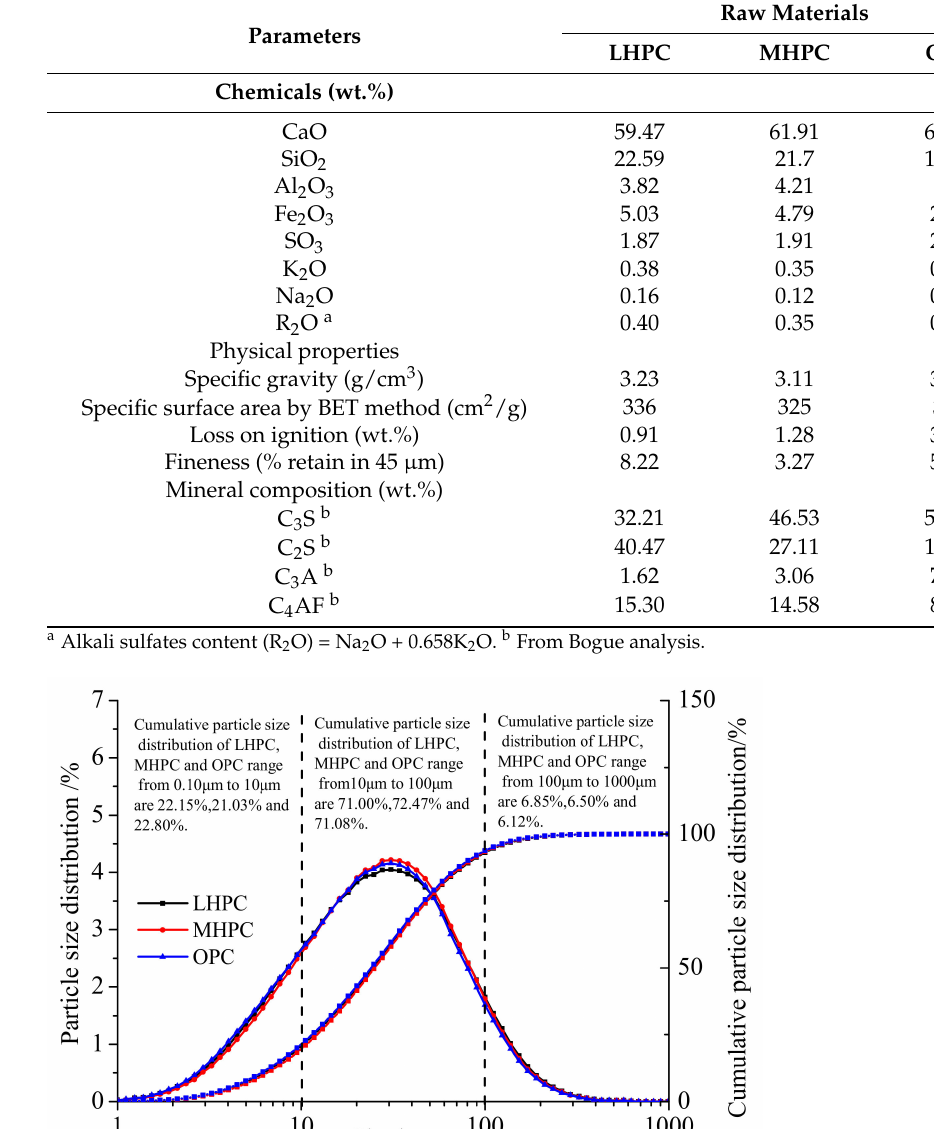
Table 1. Chemical, physical properties and mineral compositions of LHPC, MHPC and OPC.